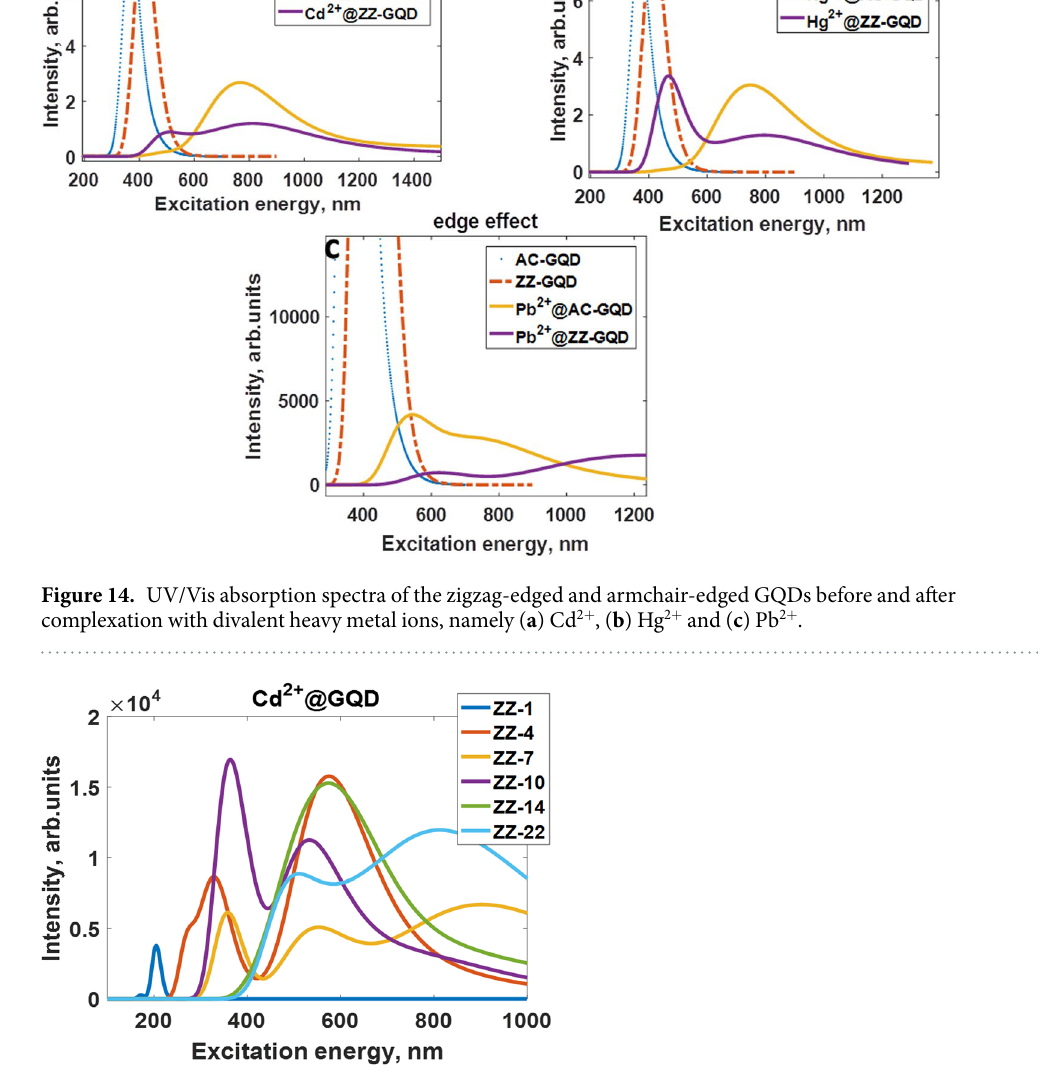
Figure 15. UV/Vis absorption spectra of the zigzag-edged GQDs after complexation with divalent Cd 2 + ions depending on the size of the GQDs. ZZ denotes a kind of edge, while the following integer corresponds to the number of hexagonal rings in